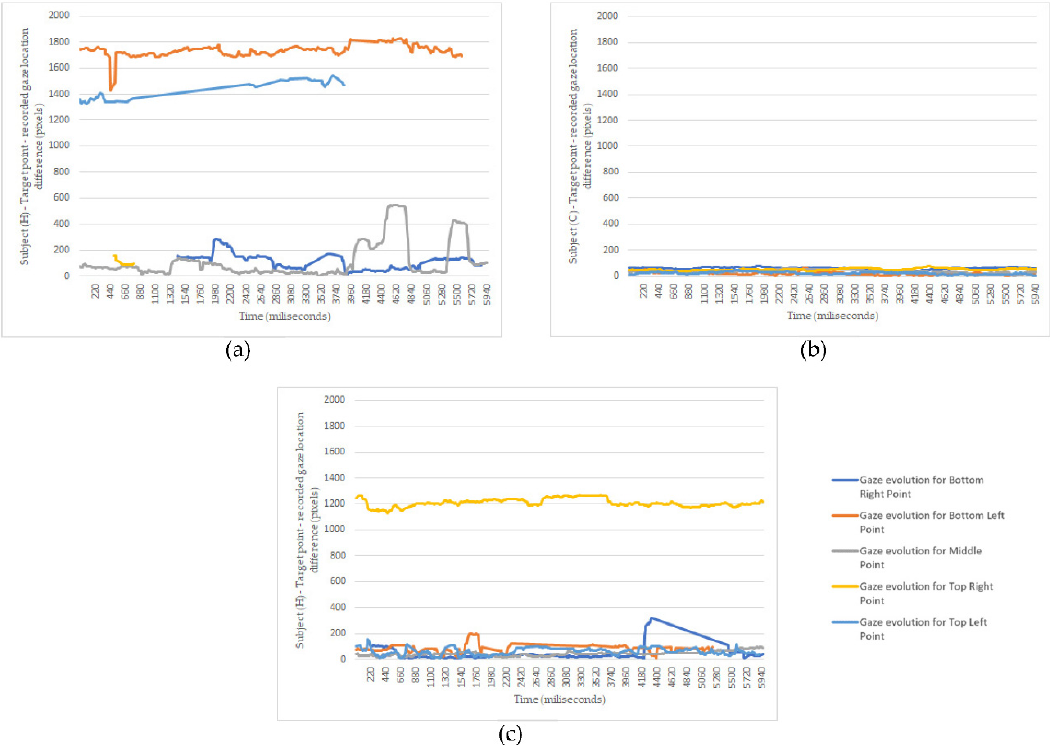
Figure 5. ( a ) The evolution in time of the difference between the target point and recorded gaze location, as determined for Subject (H). The gaze was considered for the right eye, ( b ) the evolution in time of the difference between the target point and recorded gaze location, as determined for Subject (C). The gaze was considered for the right eye, ( c ) the evolution in time of the difference between the target point and recorded gaze location, as determined for Subject (H). The gaze was considered for the left eye.